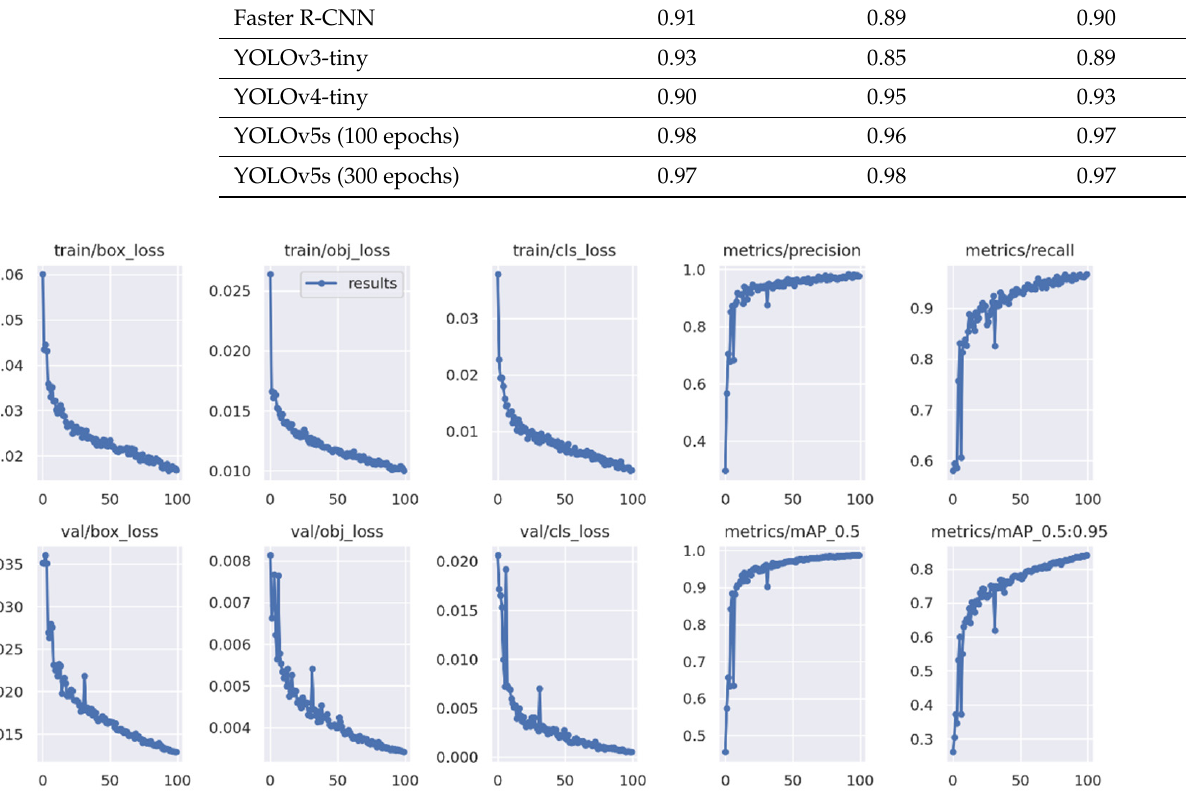
Figure 15. Integration results of YOLOv5s (100 epochs).